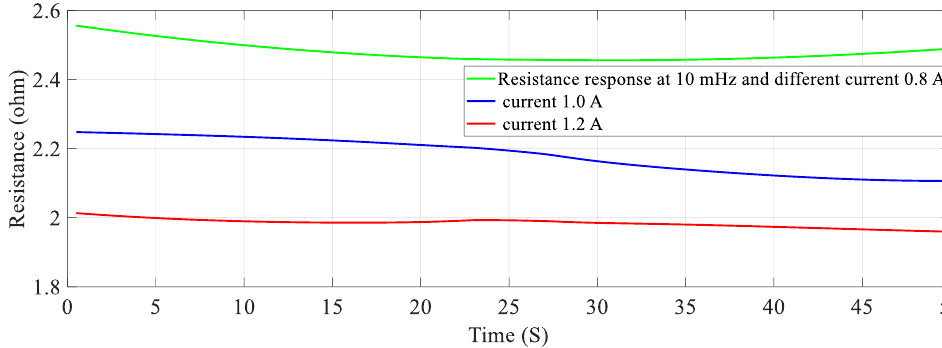
Figure 7. Resistance of SMA spring actuator at different current.